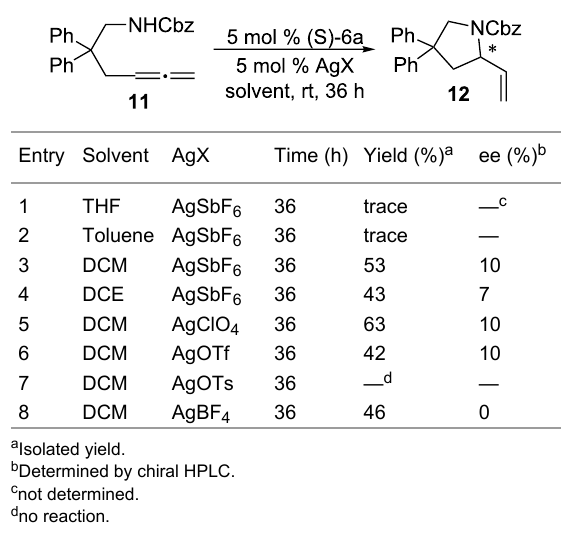
Table 3: NHC–Au complex ( S )- 6a catalyzed asymmetric intramolec- ular